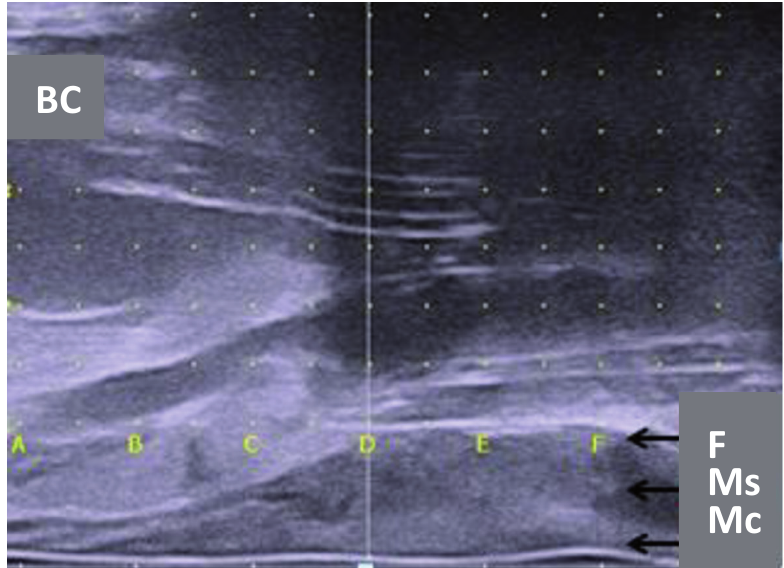
that you are in the